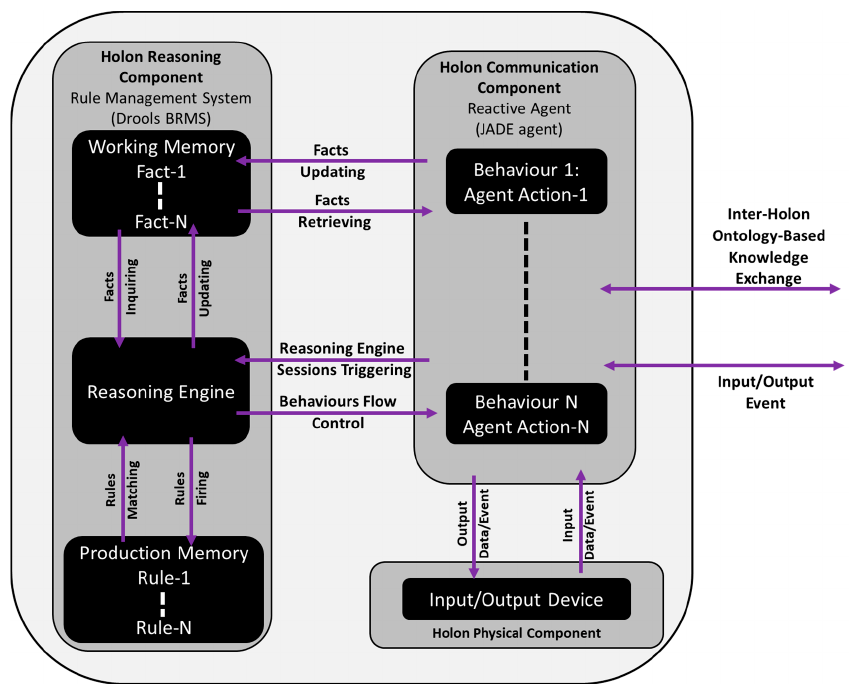
Figure 9. Proposed Holon Model.